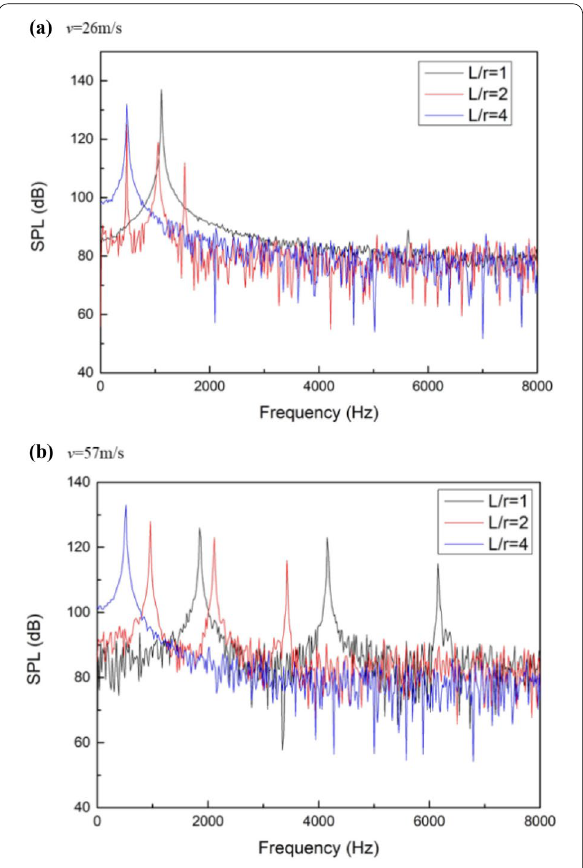
Figure 7 Plots of acoustic pressure